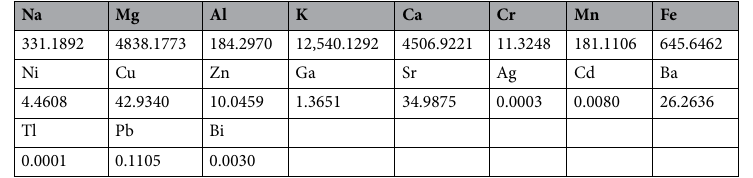
Table 10. Bottom ashes express in